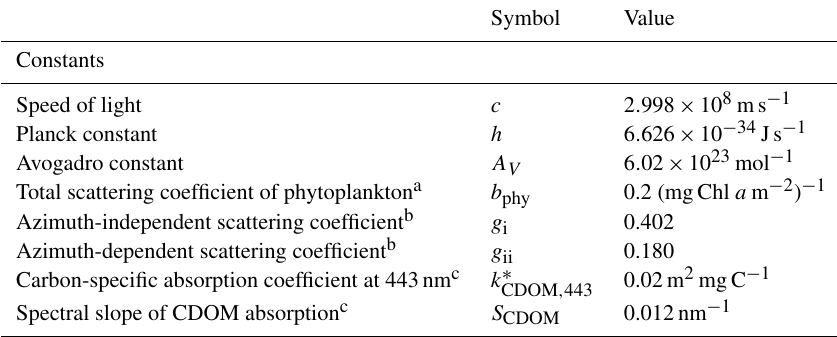
Figure 8. The remote-sensing reflectance of the 21 mineral mixtures suspended in water as measured by Stramski et al. (2007). Laboratory measurements of absorption and scattering properties are used to calculated remote-sensing reflectance (Baird et al., 2016b). Line colouring corresponds to that produced by the mineral suspended in clear water as calculated using the MODIS true colour algorithm (Gumley et al., 2010). CAL1, with a median particle diameter of 2µm, is used for Mud CaCO . 3 Table 1. Constants and parameter values used in the optical